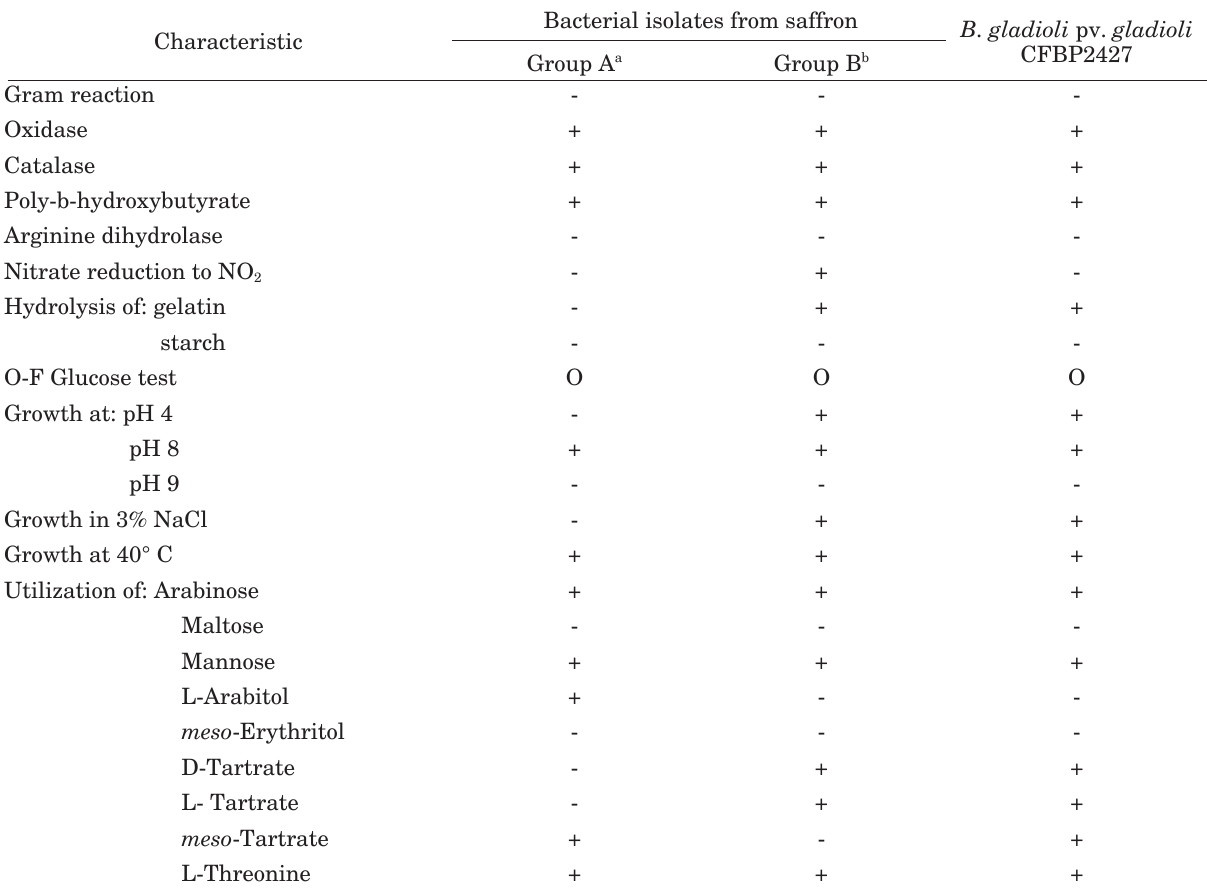
Table 1. Main characteristics of bacterial isolates from saffron and B. gladioli pv. gladioli CFBP2427 type strain.